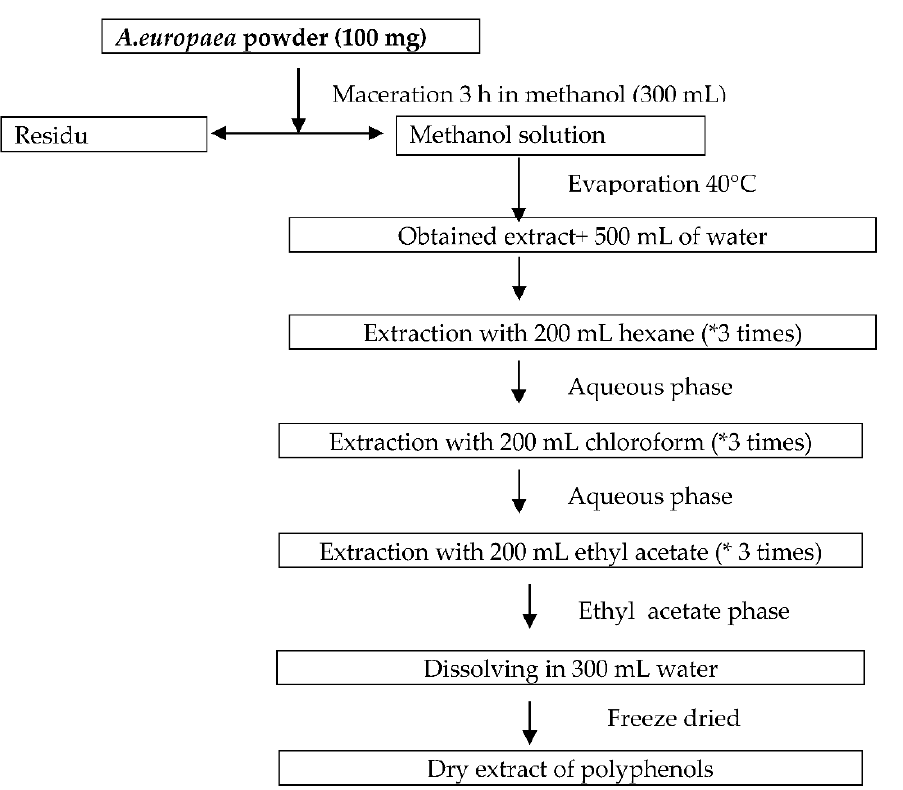
Figure 2. Schematic drawing of liquid-liquid extraction of polyphenol-rich fraction from A. europaea .